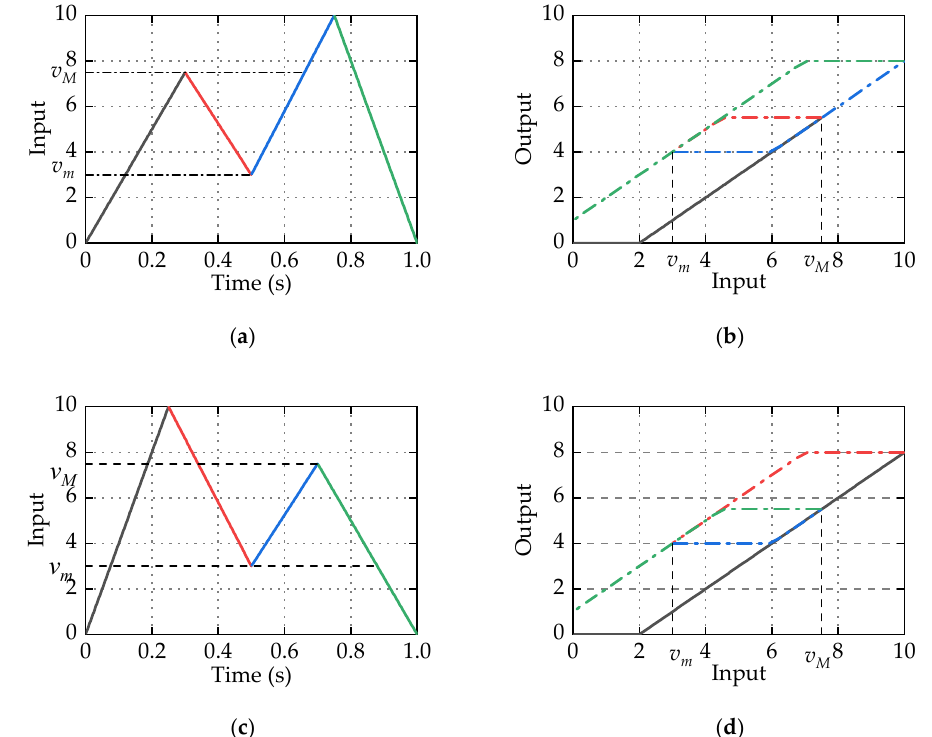
Figure 6. Hysteresis loops of M-Play operator with different input history in the same input range. ( a ) Input history 1; ( b ) hysteresis curve generated by input history 1; ( c ) input history 2; ( d ) hysteresis curve generated by input history 2